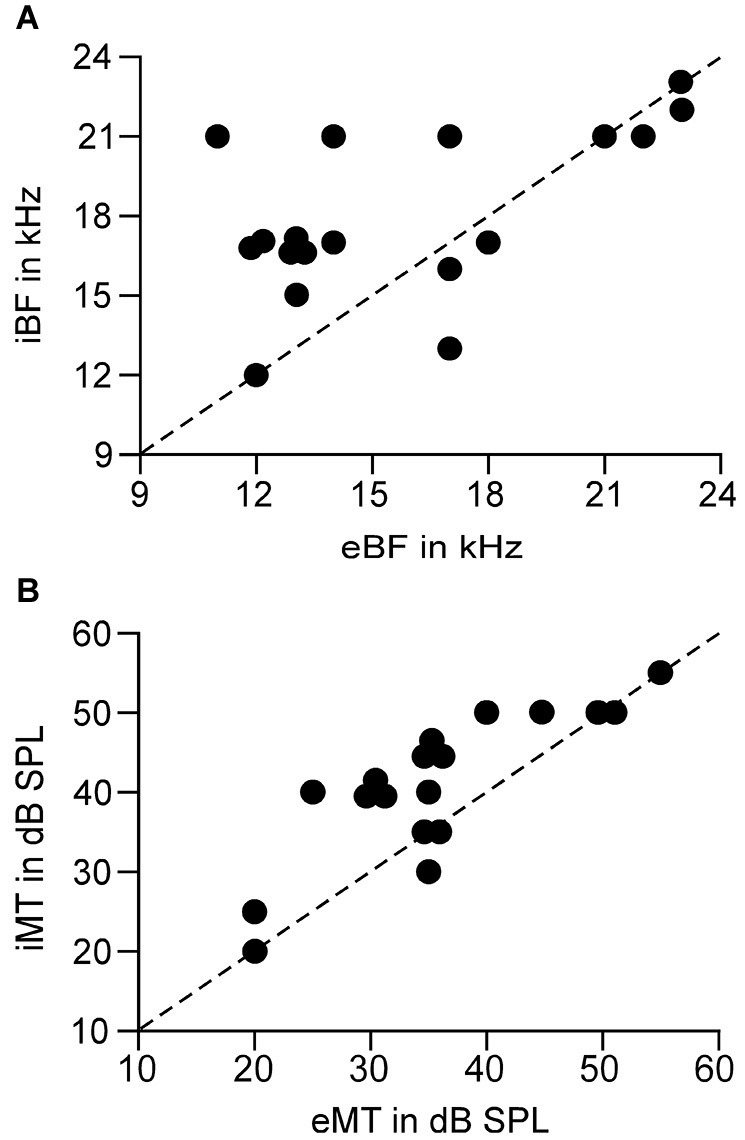
Correlation of the BFs (A) and MTs (B) between the EPSC and IPSC of a single neuron. Dashed line is the diagonal. Circles on the diagonals show the identical BF or MT between EPSC and IPSC. eBF/iBF: BF of EPSC and IPSC. eMT/iMT: MT of EPSC and IPSC.